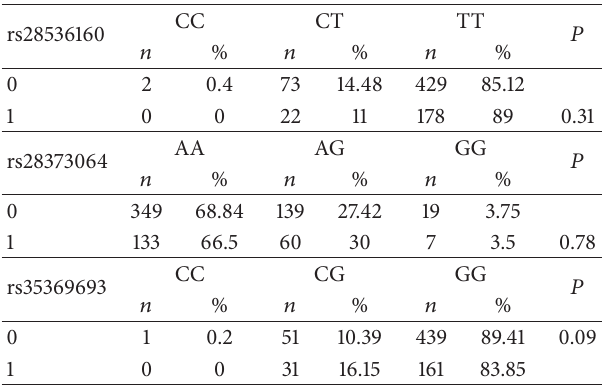
Table 2: Polymorphisms in AVPR1b gene